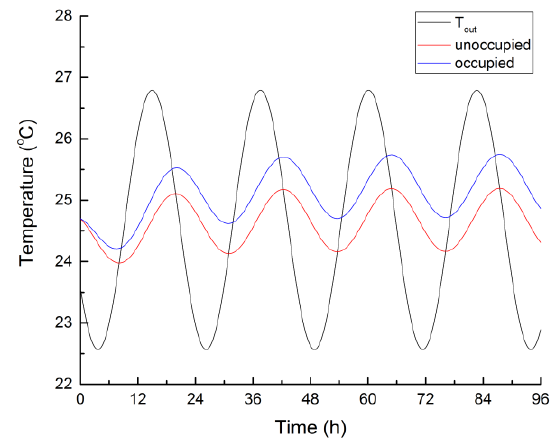
Figure 5. Diurnal variation of outdoor and indoor air temperature.